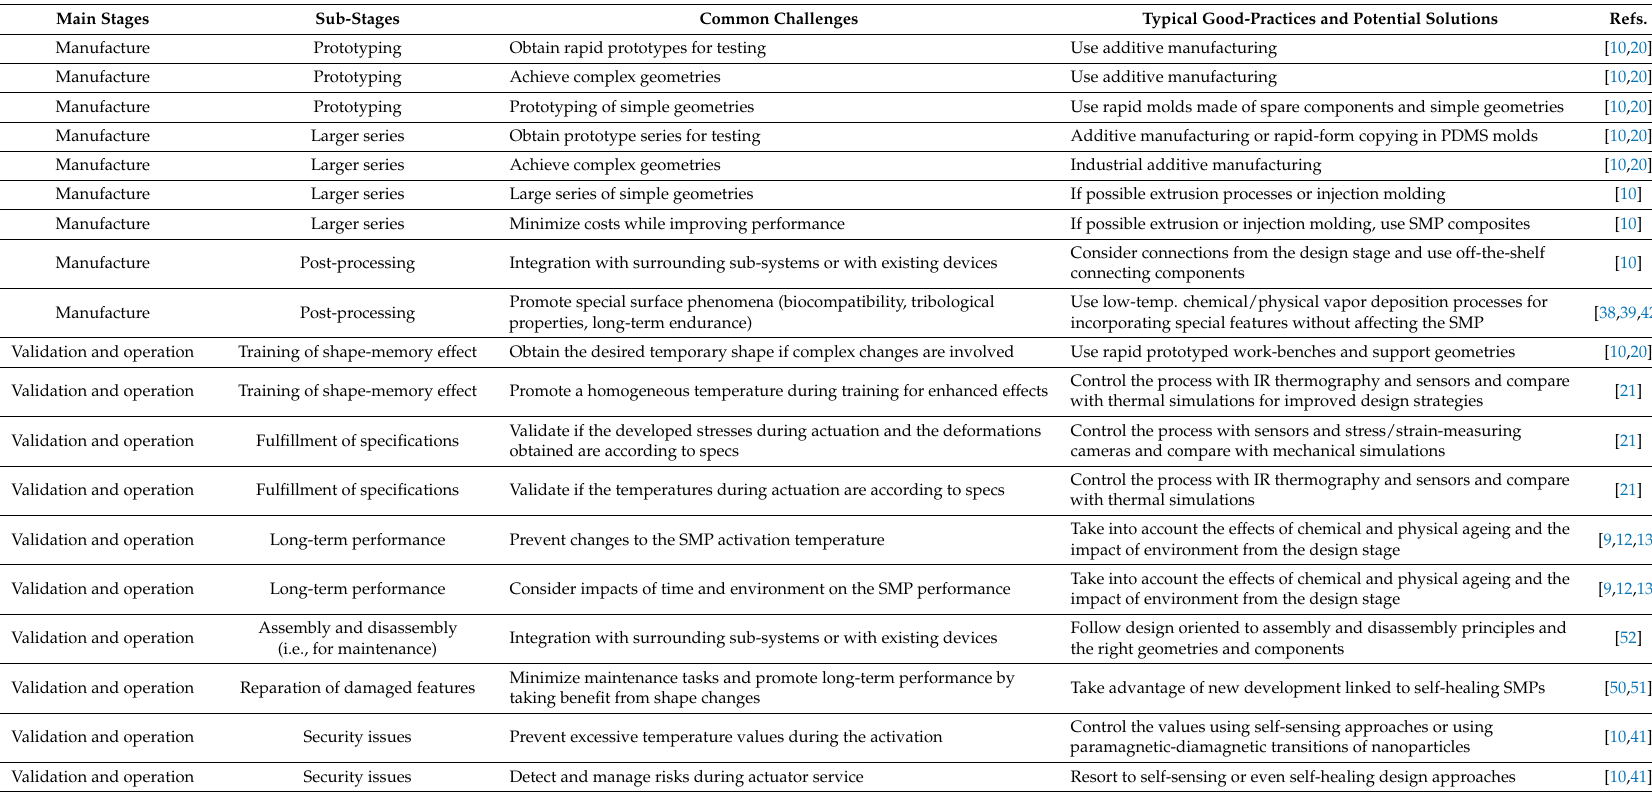
Table 2. Main challenges and solutions in the manufacturing and validation stages for the development of “smart” systems based on shape-memory